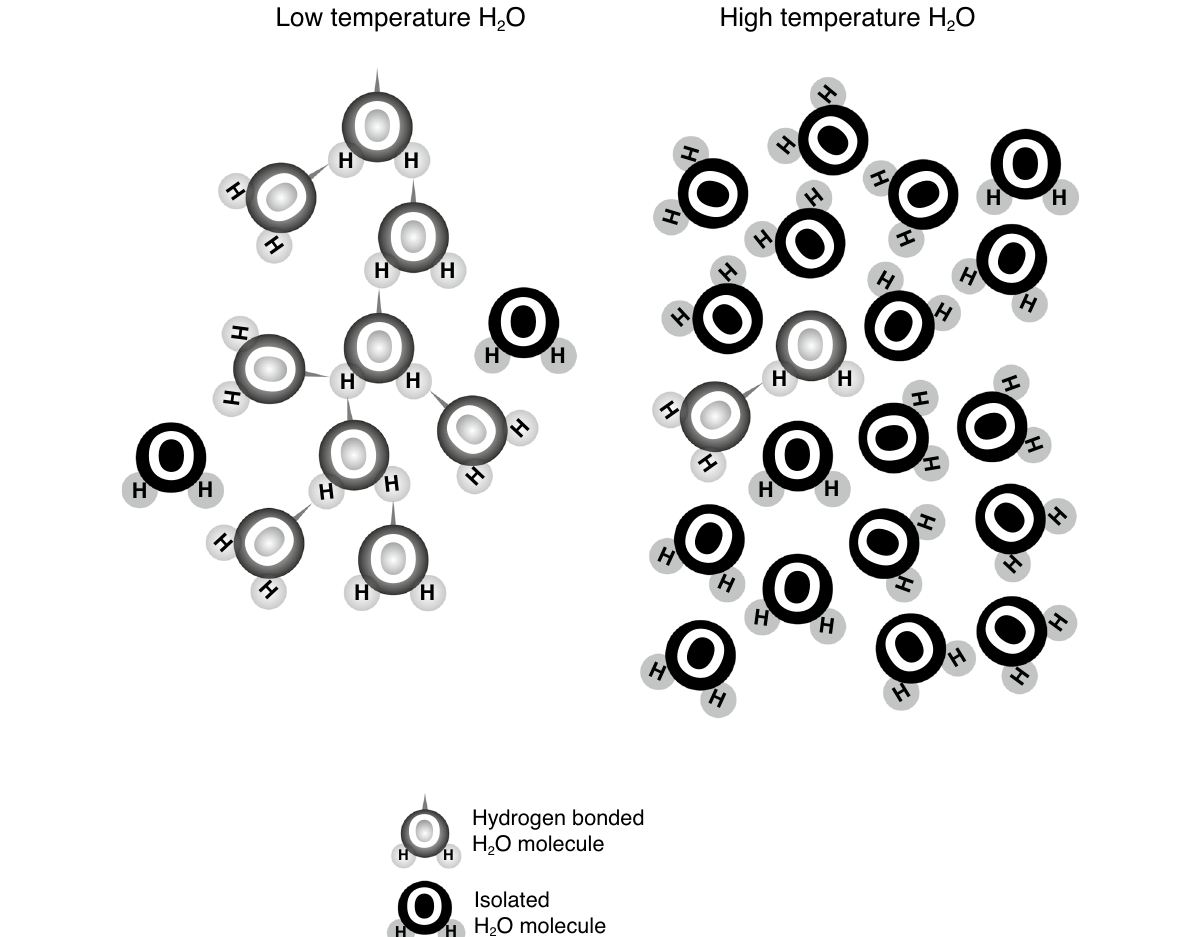
Fig. 29 Schematic representation of the structure of H 2 O at low temperature with about 80% of the H 2 O molecules connected with hydrogen bonding (long arrow between H and O atoms) and high temperature with about 10% hydrogen bonding and the result of H 2 O molecules isolated from one